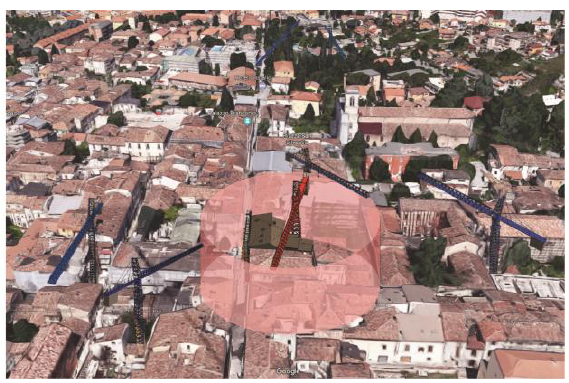
Figure 5. Study of the crane's radius and the presence of other active building site in the immediate vicinity.